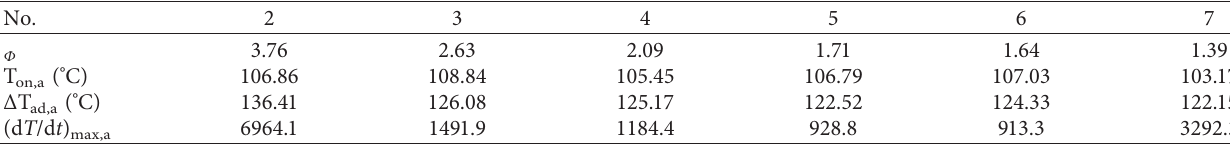
Table 7: Adiabatic test results of sample #2 corrected by the Fisher method.